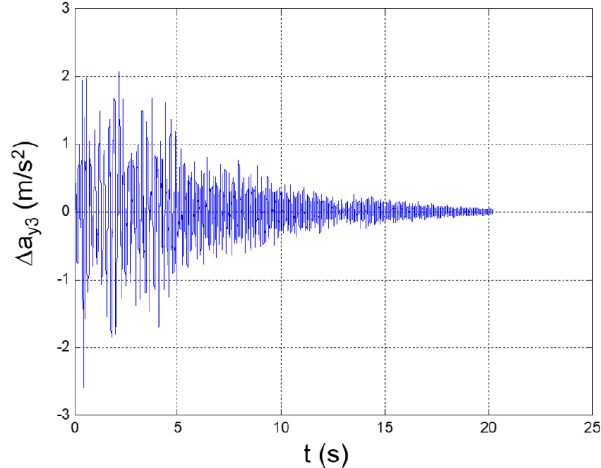
Figure 11. Seismic response, interstory acceleration at the 2nd floor ( Δ 𝑎 y2 = 𝑎 y2 − 𝑎 y1 ).